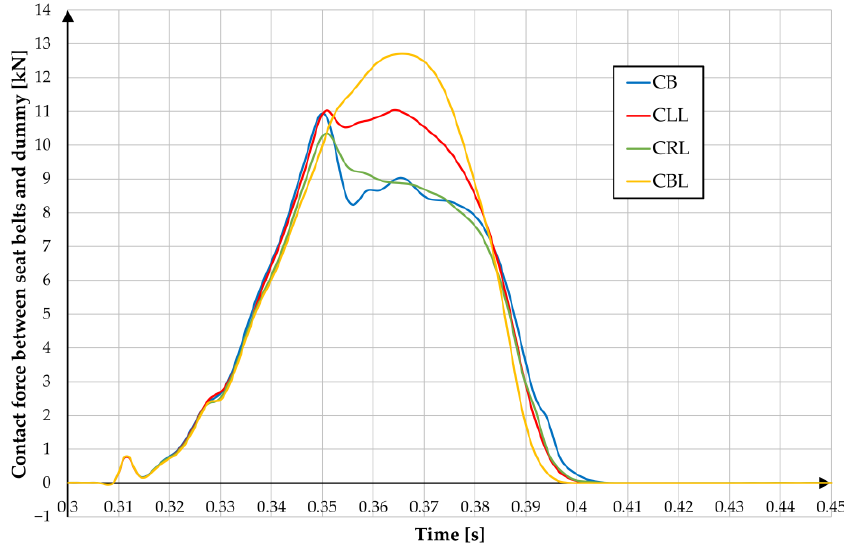
Figure 16. Comparison of contact force between the seat belts and the dummy. The use of additional equipment for the DP, in addition to influencing lateral dis- placement, shoulder rotation and the course of force between the belts and the dummy, also affects skull injuries expressed as HIC (Head Injury Criterion) (Figure 17). Compared to RD, HB and CB have at least 6% lower HIC15 and 7% lower HIC36 values.